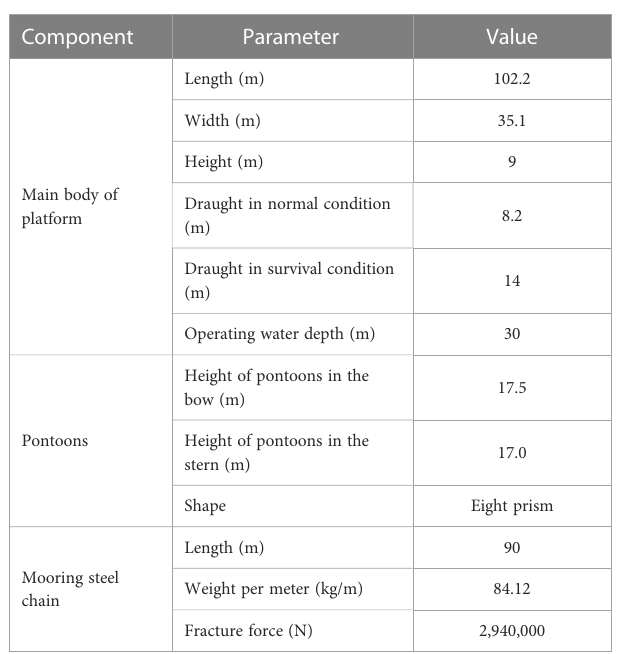
TABLE 1 Fish farm platform parameters.